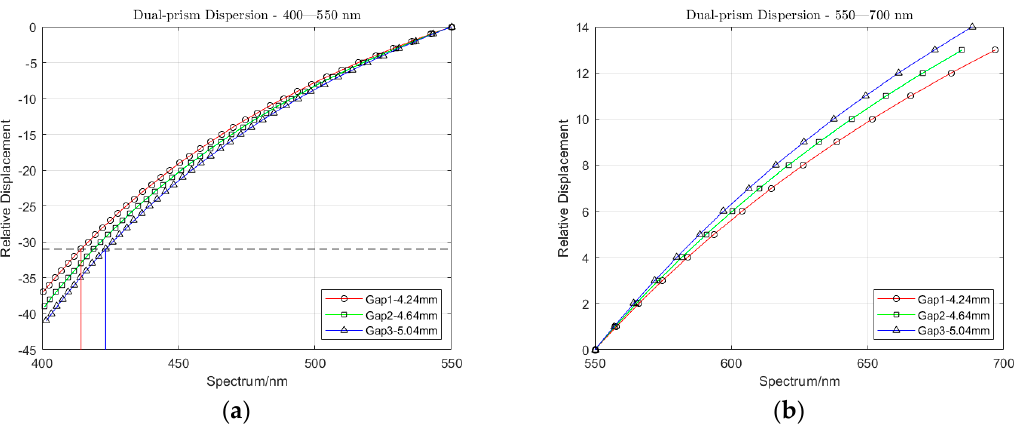
Figure 4. The dispersion of the dual-prism for three air gaps of 4.24 mm, 4.64 mm, and 5.04 mm in the spectral region of: ( a ) 400–550 nm, ( b ) 550–700 nm. The y -axis presents the location of pixels along the dispersion plane with respect to the pixel that senses the 550 nm wavelength (the central wavelength position) which is set at 0 mm.